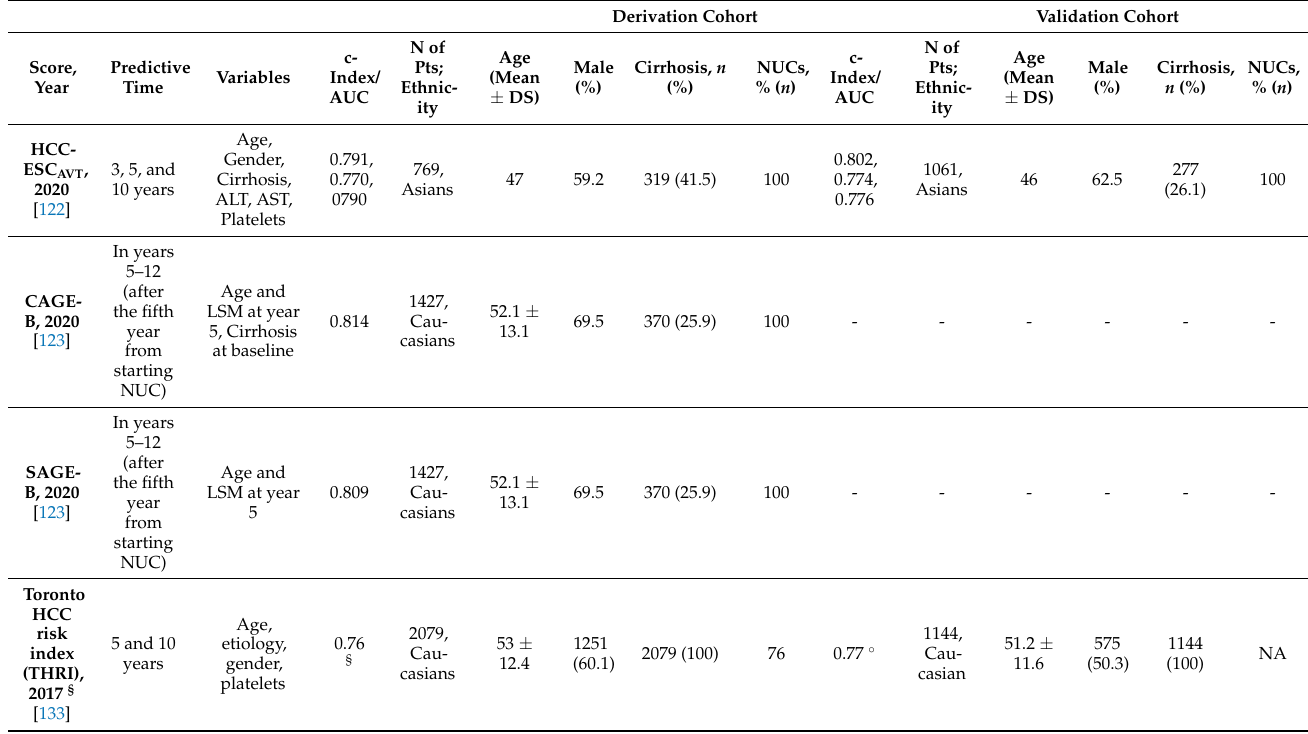
Table 2. Cont. Derivation Cohort Validation